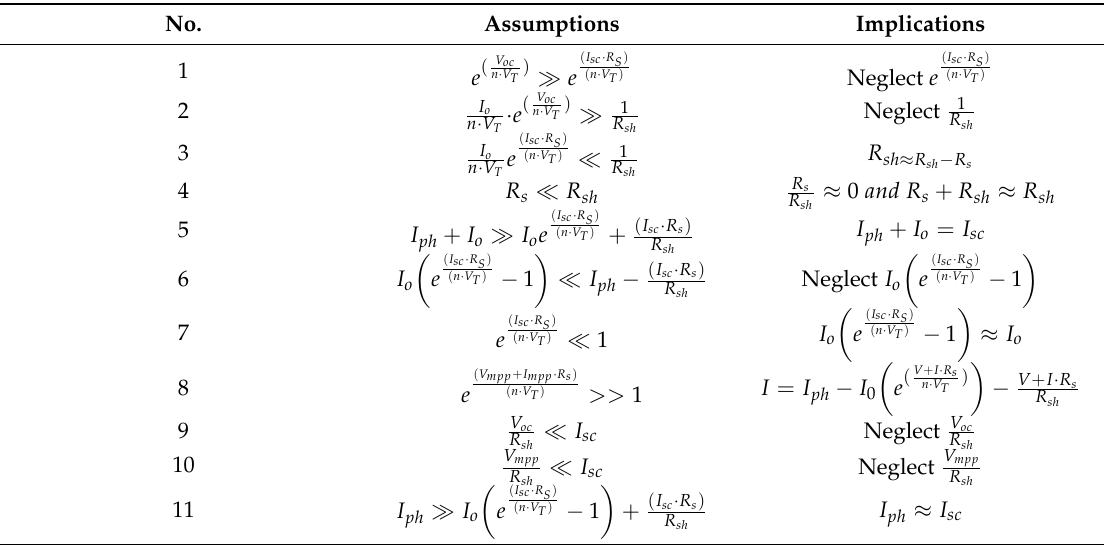
Table 2. Common assumptions in exact